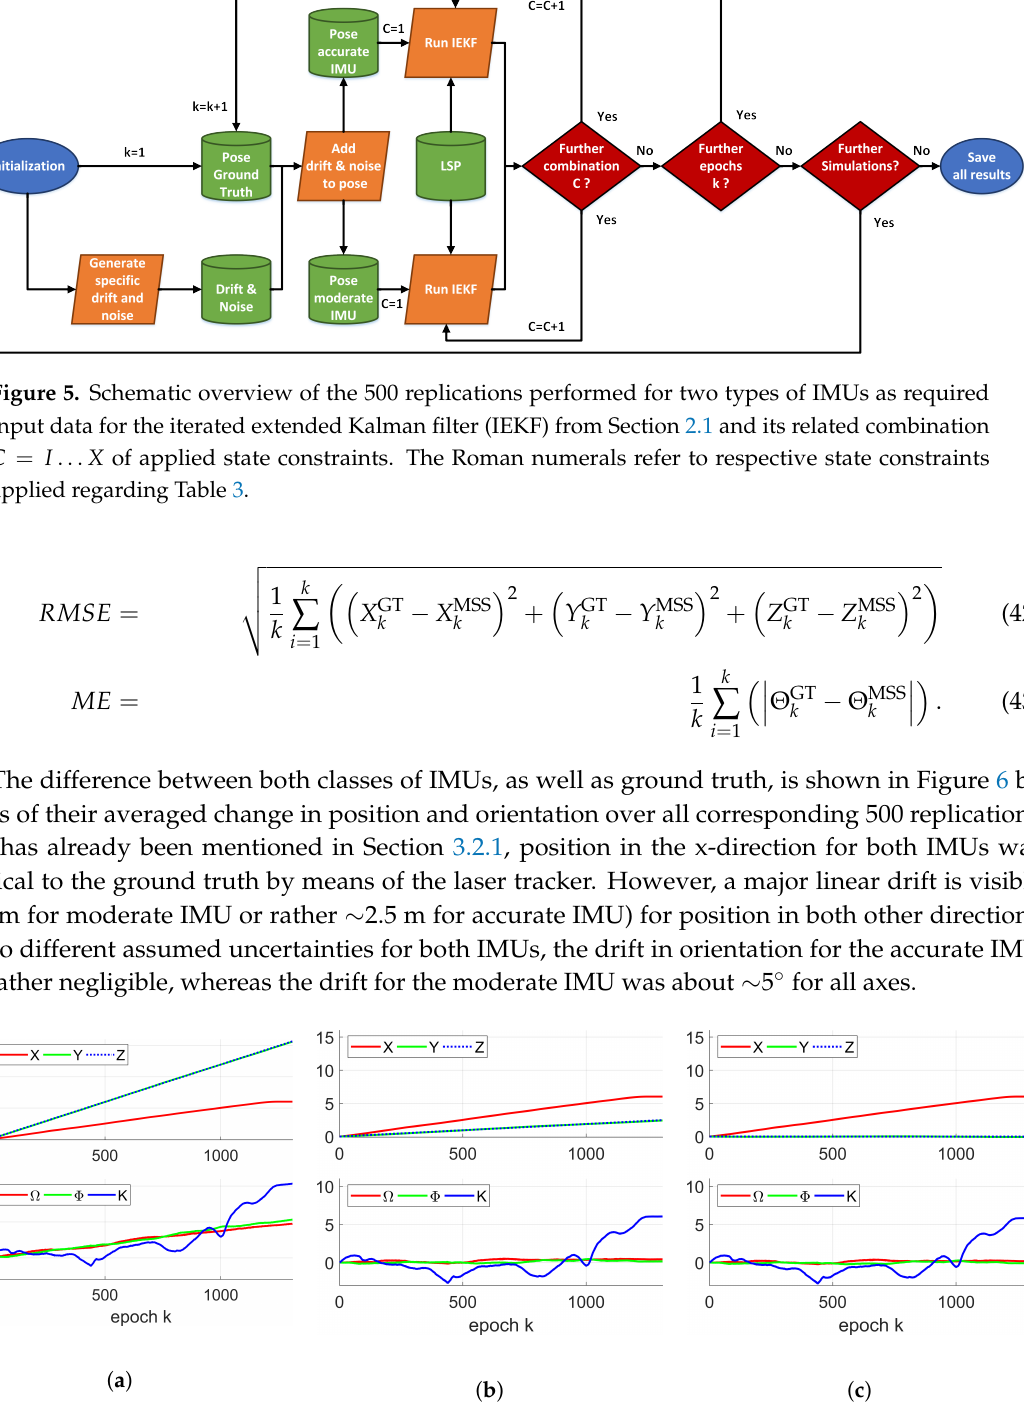
Figure 6. Mean change in position (top) and orientation (bottom) of the kinematic MSS by means of 500 simulated moderate IMU poses ( a ) and accurate IMU poses ( b ) over K epochs. True change in position (top) and orientation (bottom) of the kinematic MSS by means of laser tracker pose ( c ) over K